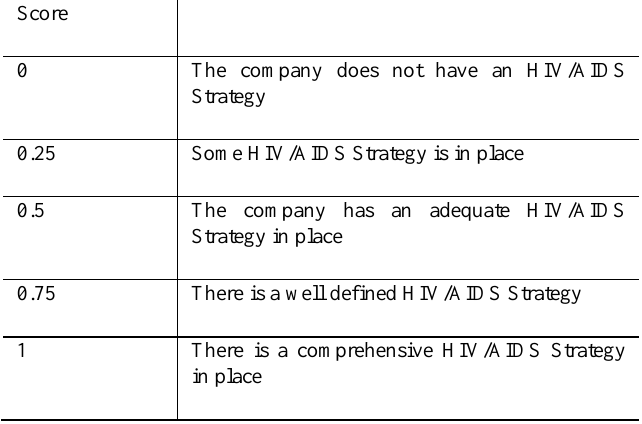
Table 2: Scoring table: Example of the criterion HIV/AIDS